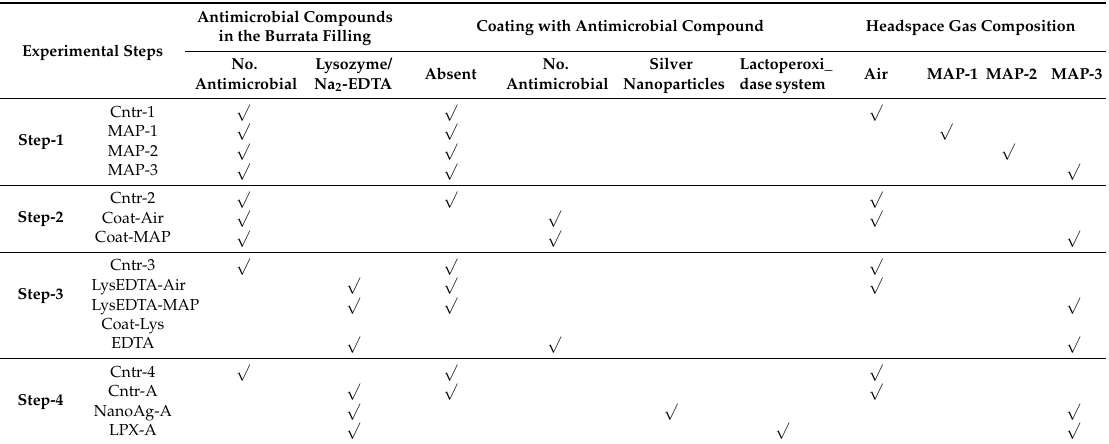
Table 1. Experimental step to improve burrata cheese shelf